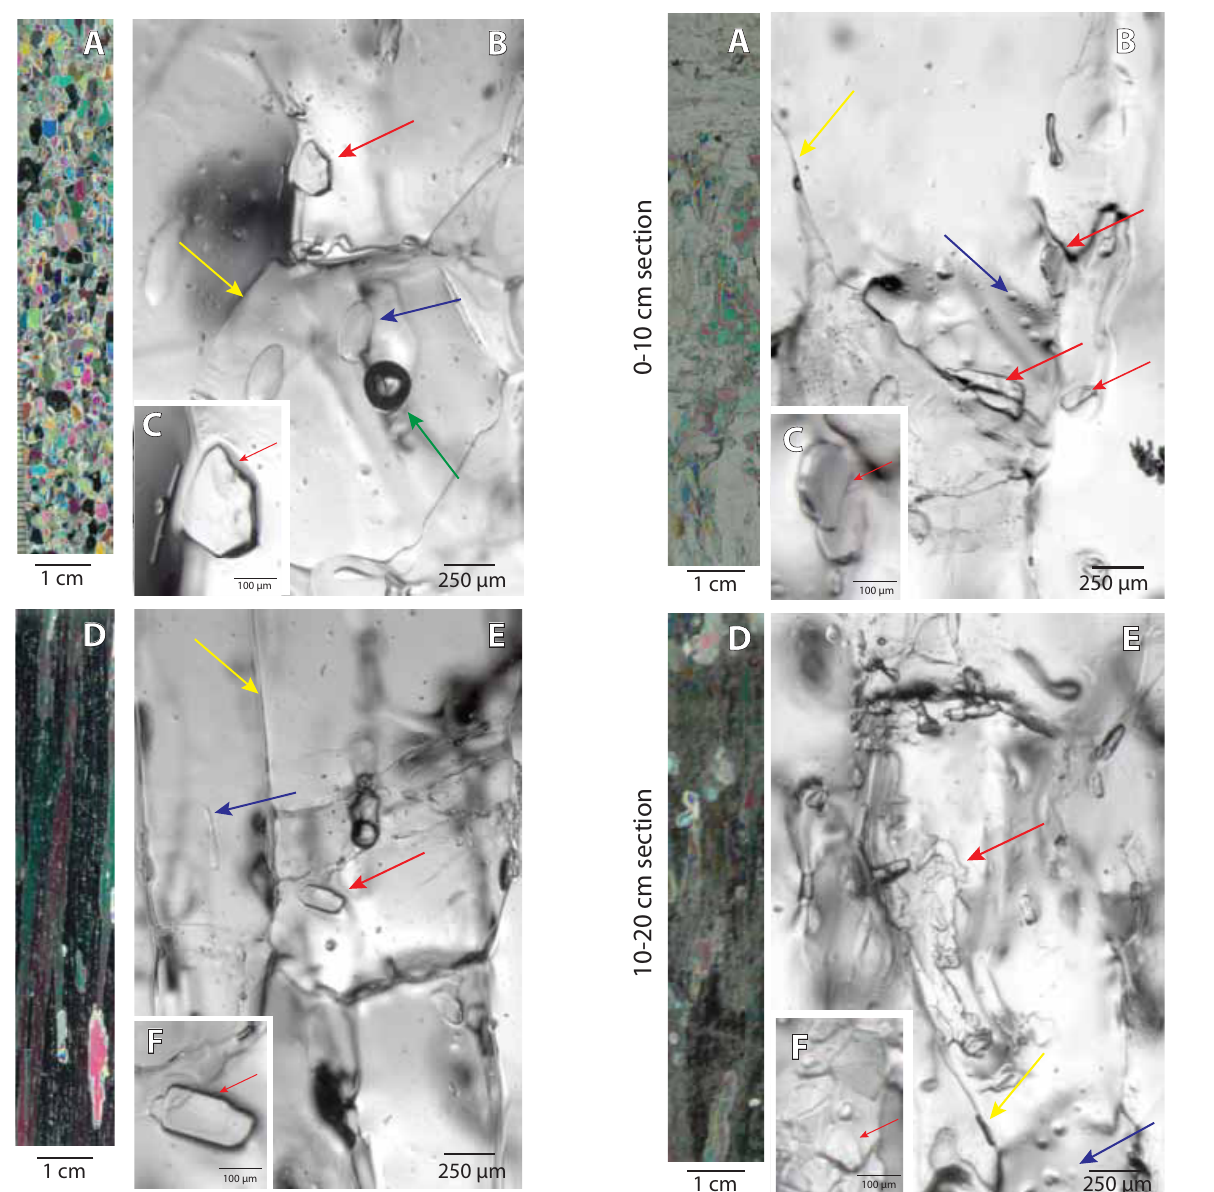
light, suggesting that they were simple single crystals. All